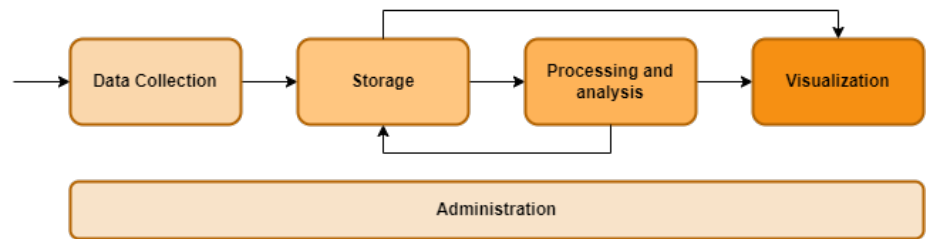
Figure 11. Functional modules of the system for energy consumption.